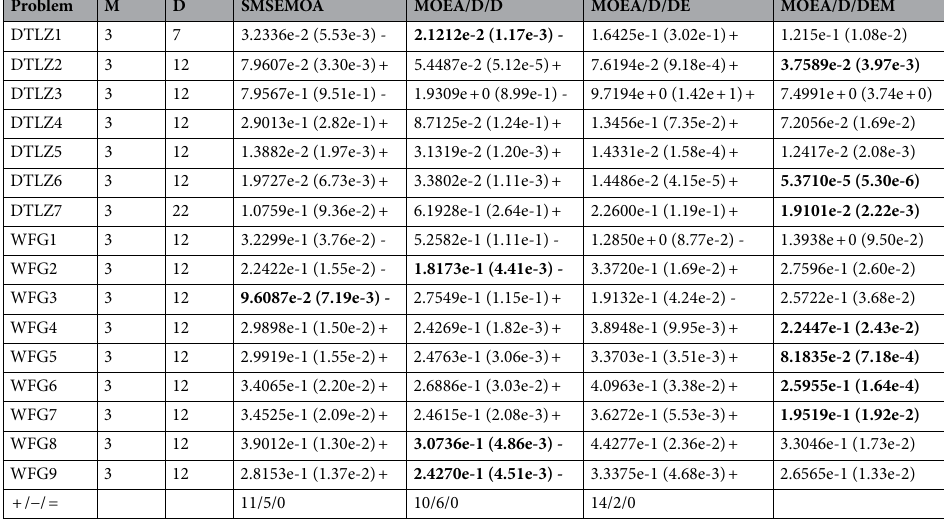
Table 1. IGD values of 7 algorithms in 16 problems. The best of the comparison results are in [bold].